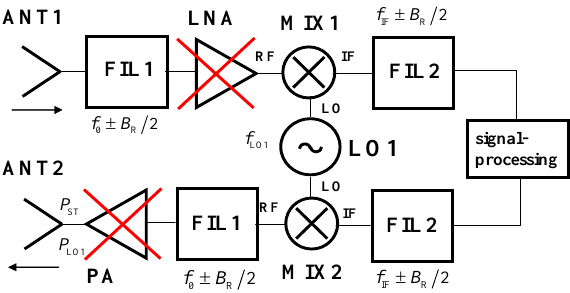
Figure 4. TS block diagram with common frequency converting circuits.